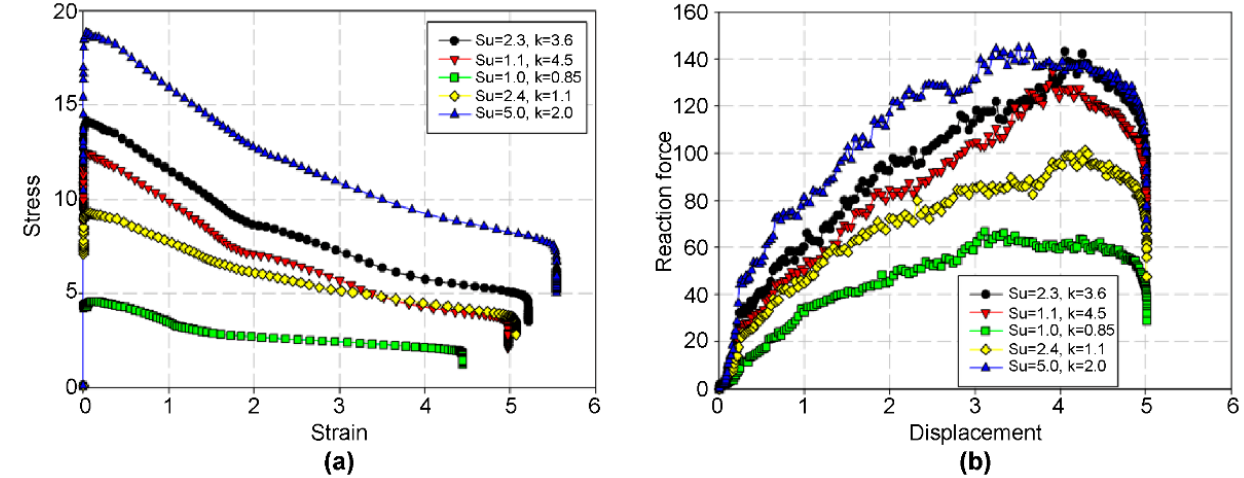
Figure 14. Results of the TBSR–VUMAT model according to undrained shear strength. ( a ) Stress– strain curve and ( b ) force–displacement curve.